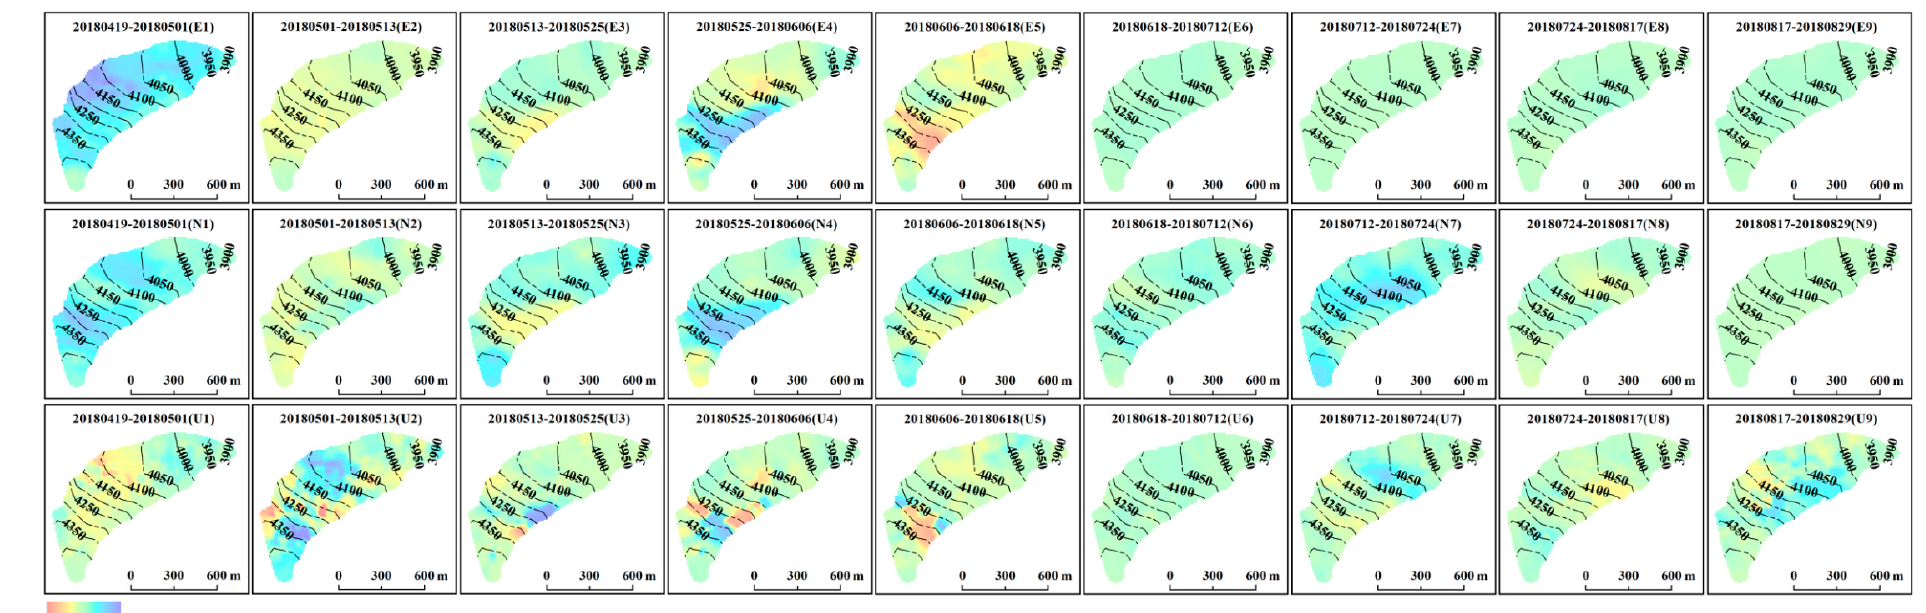
Figure 9. The motion velocity distribution of the west branch of Urumqi Glacier No. 1 in each period of time in the direction of east, north and vertical (unit: cm/d).